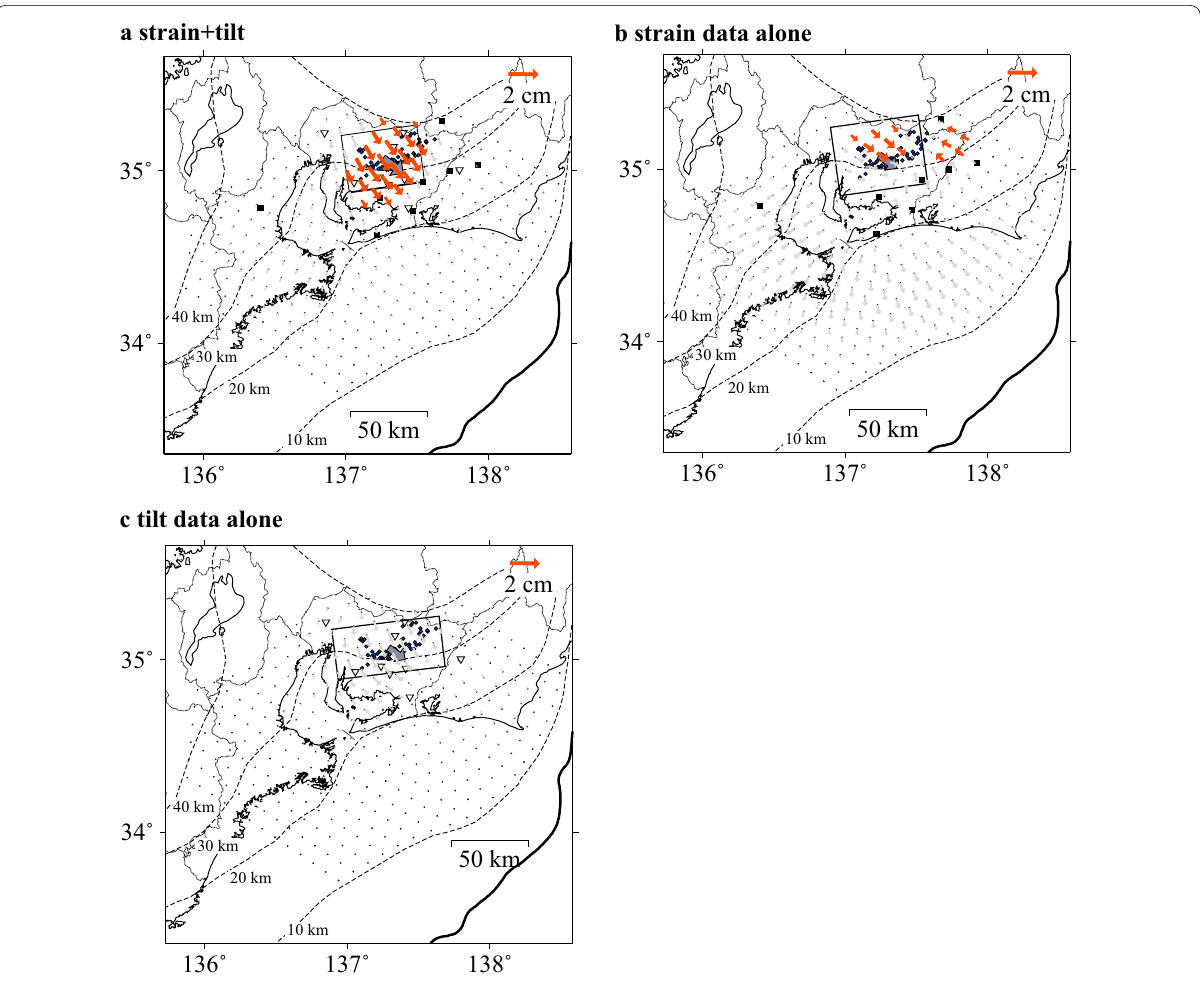
Fig. 7 Estimated slip distributions during 14–19 April 2015. Map region corresponds to Area A in Fig. 1. a Surface projection of estimated slip distribution on the plate interface (arrows) and a rectangular fault model (rectangle and gray arrow). Slips exceeding the standard deviation (1 σ ) are shown in red and slips below the 1 σ are shown in light pink. Colored dots are LFT epicenters during 14–19 April (see Fig. 5). The solid line indicates the Nankai Trough and dashed contours indicate the depth of the Philippine Sea plate. b Surface projection of estimated fault slip on the plate interface and rectangular fault model based on strain data alone. c Surface projection of estimated fault slip on the plate interface and rectangular fault model based on tilt data